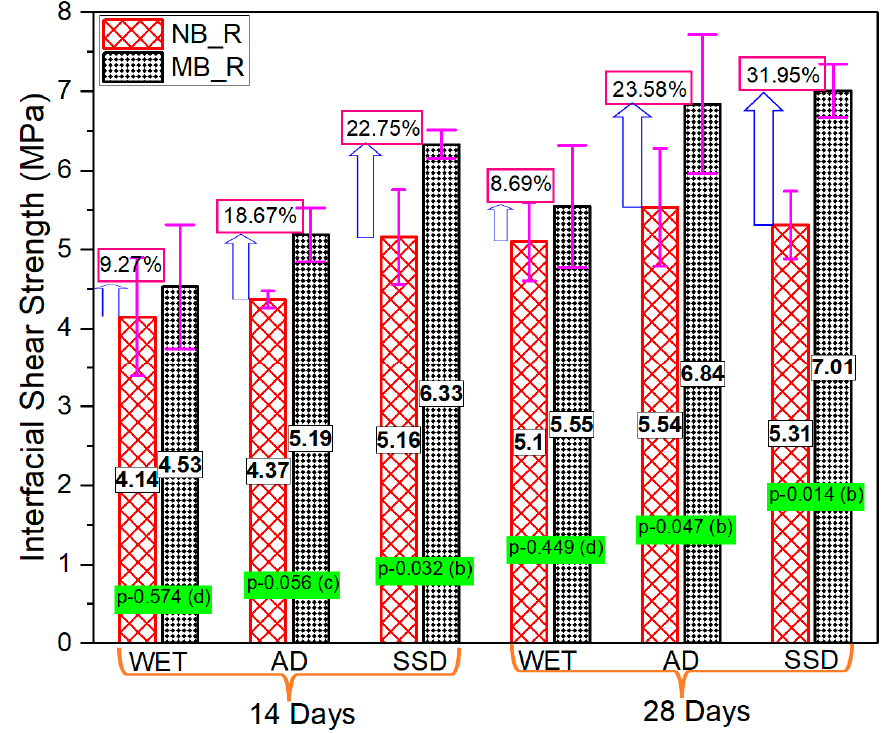
Figure 17. Influence of silica fume on bonding performance with different moisture conditions.